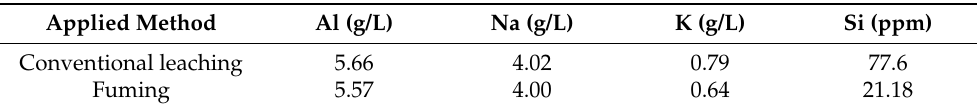
Table 2. Concentration of pregnant liquid solutions from conventional leaching and fuming tests in Al, Na, K and